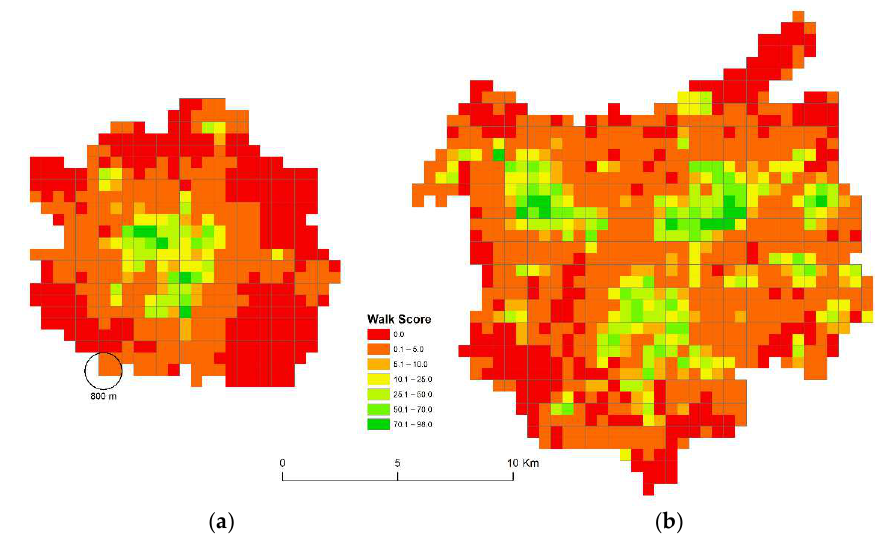
Figure 13. WS for elderly (800 m radius, Hradec Kralove ( a ), Ostrava ( b )).